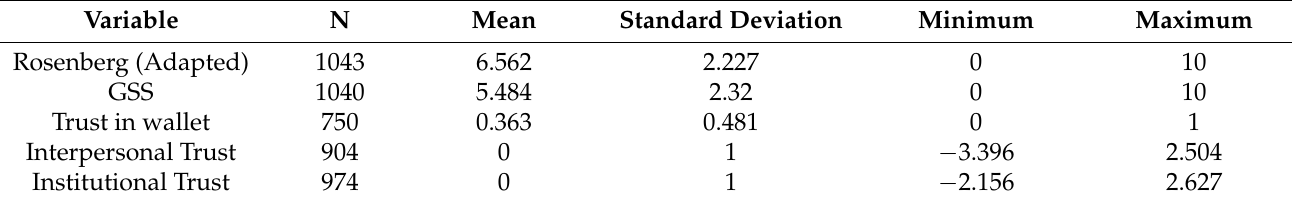
Table A1. Summary statistics of self-reported measures of trust.